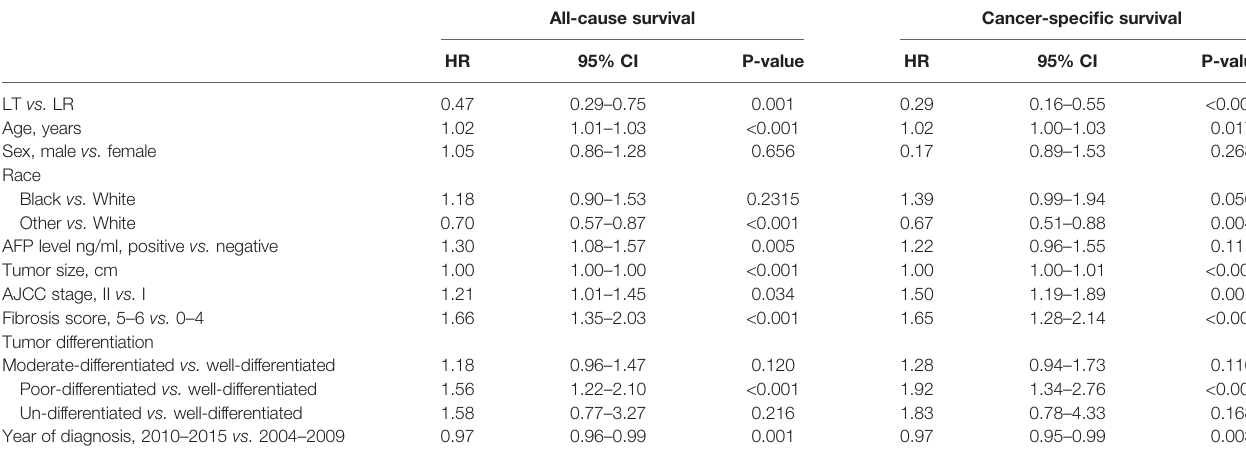
TABLE 2 | Instrumental variable analysis of the impact of surgery methods (LT vs. LR) on survival for patients with hepatocellular carcinoma in 2SRI IV Model. All-cause survival